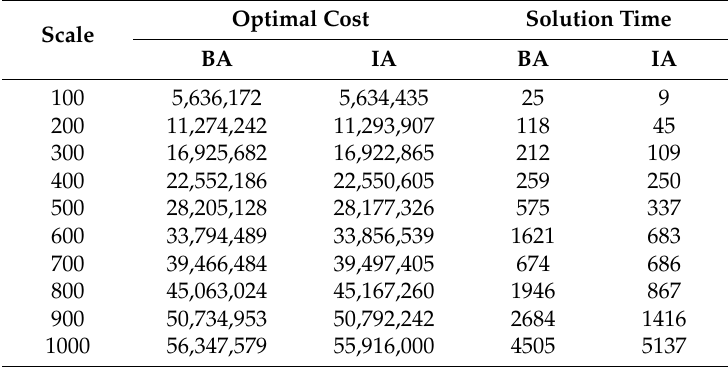
Table 2. Comparison of performance in large scale (gap: 1%).